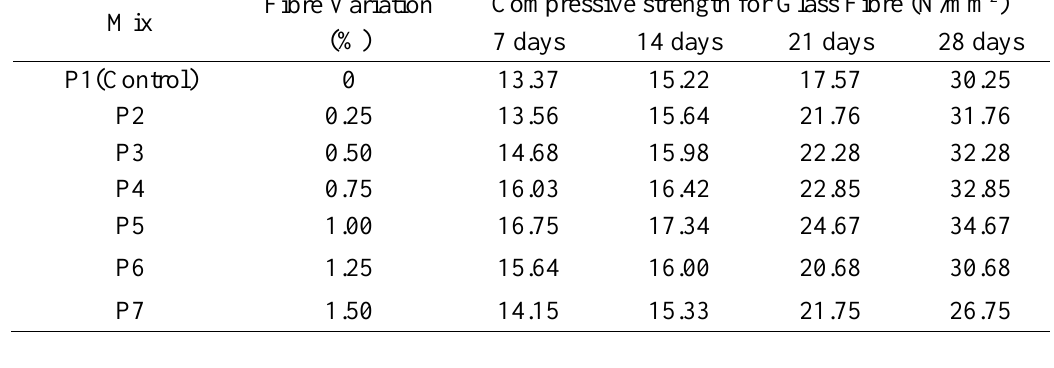
Table 4. Compressive strength for sisal fibre